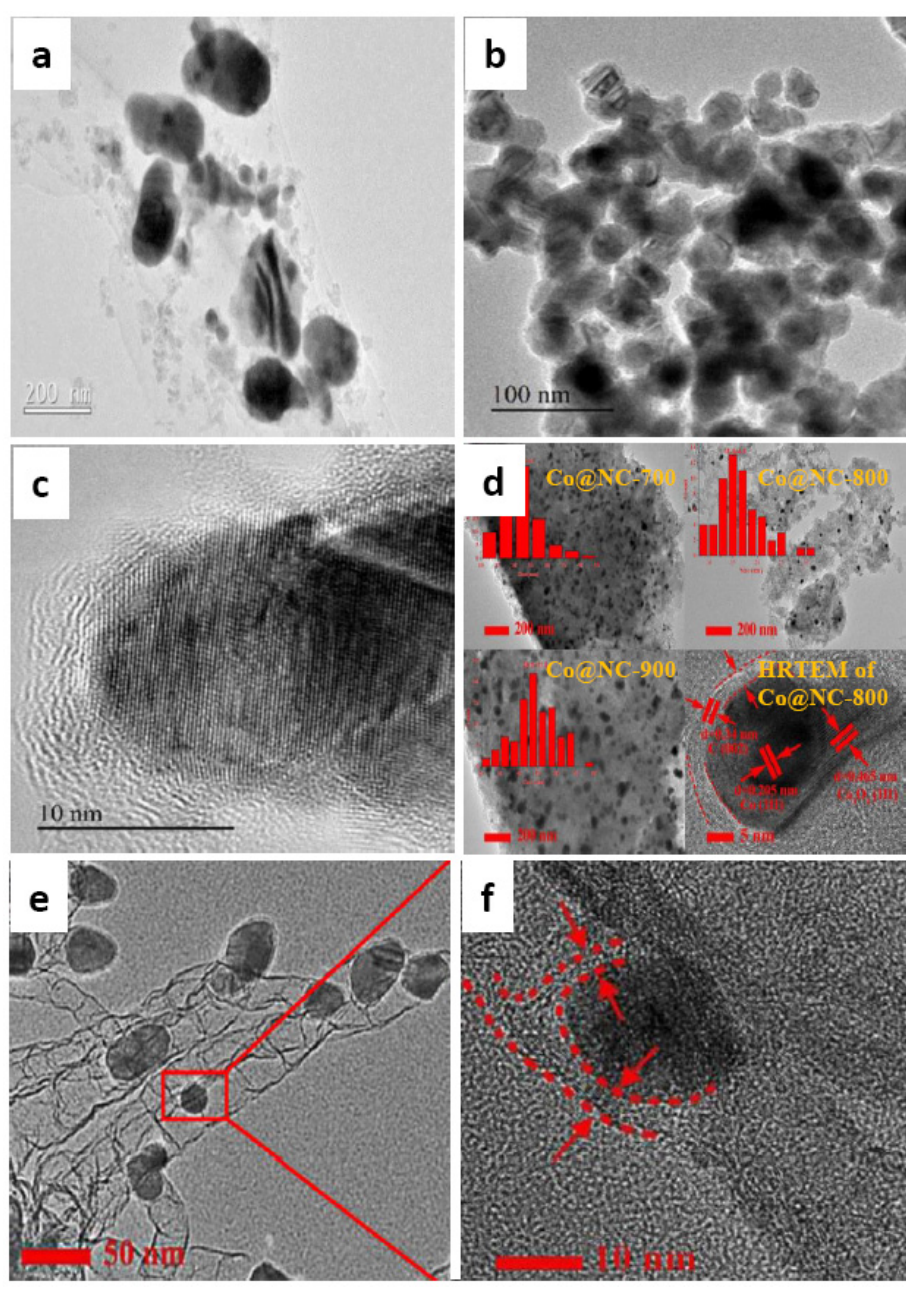
Figure 12. ( a ) TEM image of 4Co/ γ‐ Al 2 O 3 . Reproduced with permission from Reference [58]. Copy